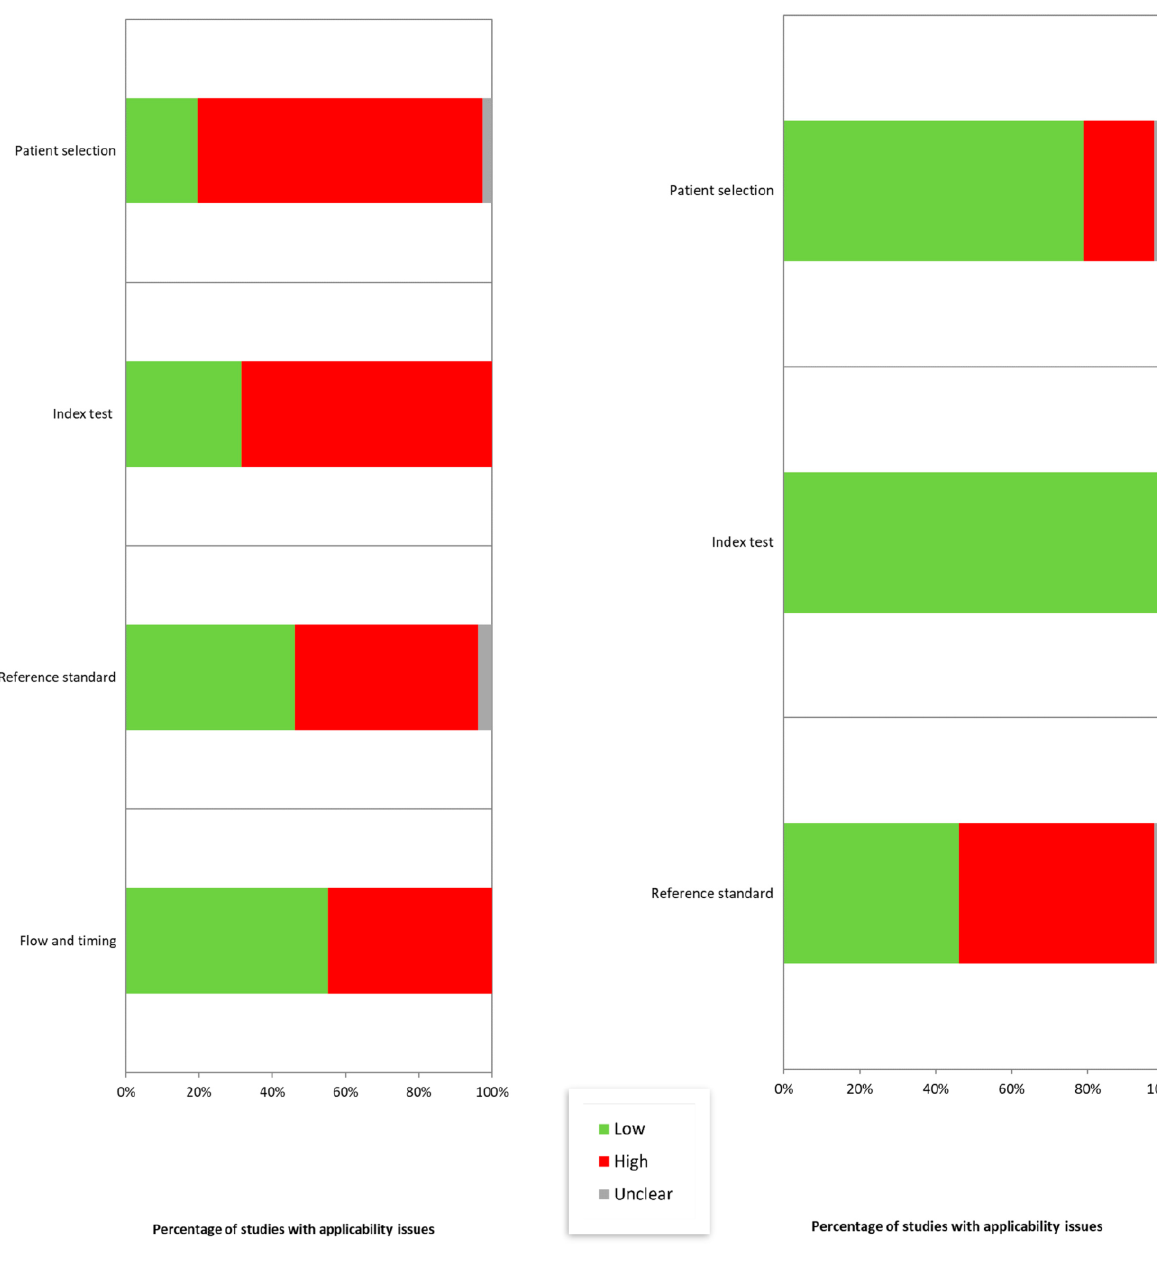
Figure 7. Quality assessment with the QUADAS-2 tool [9].